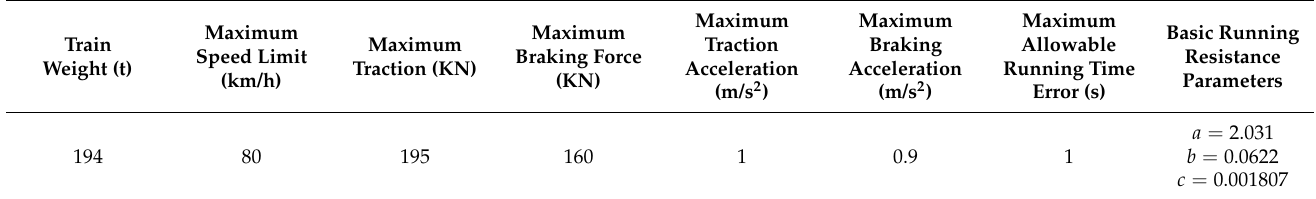
Table 2. Basic parameters of trains.